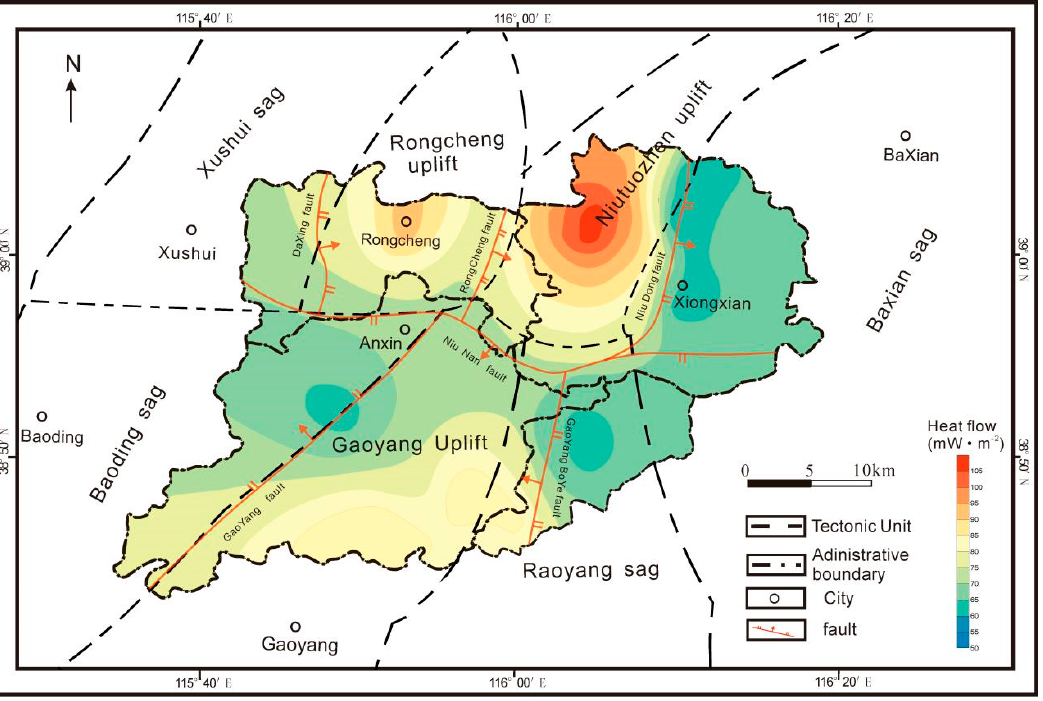
Figure 13. Geothermal heat flow distribution map of the Xiong’an New Area.